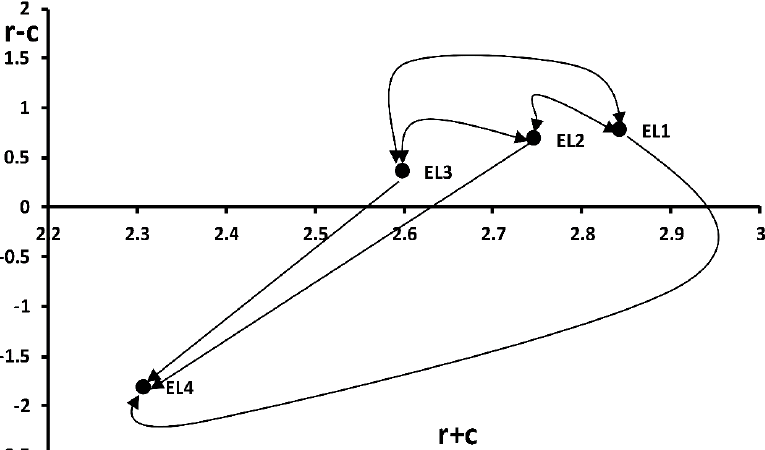
Figure 5. The cause and effect relationship map for electrical FMs.